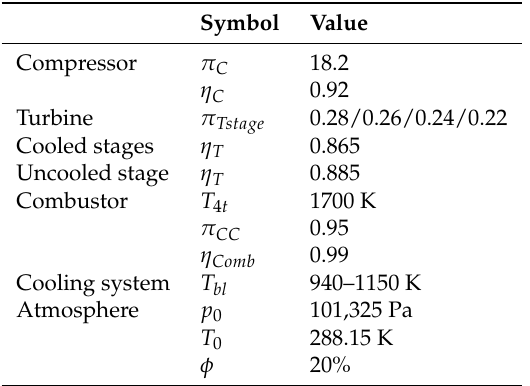
Figure 4. Schematic of the reference gas turbine model.